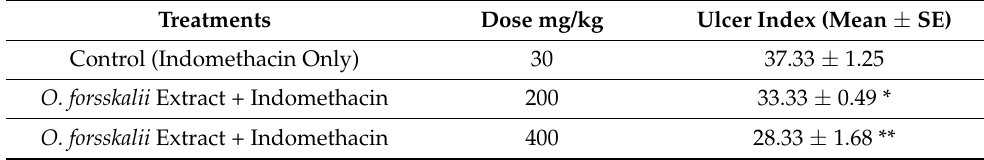
Table 2. Effect of O. forsskalii on indomethacin-induced gastric mucosal lesions. Treatments Dose mg/kg Control (Indomethacin Only)